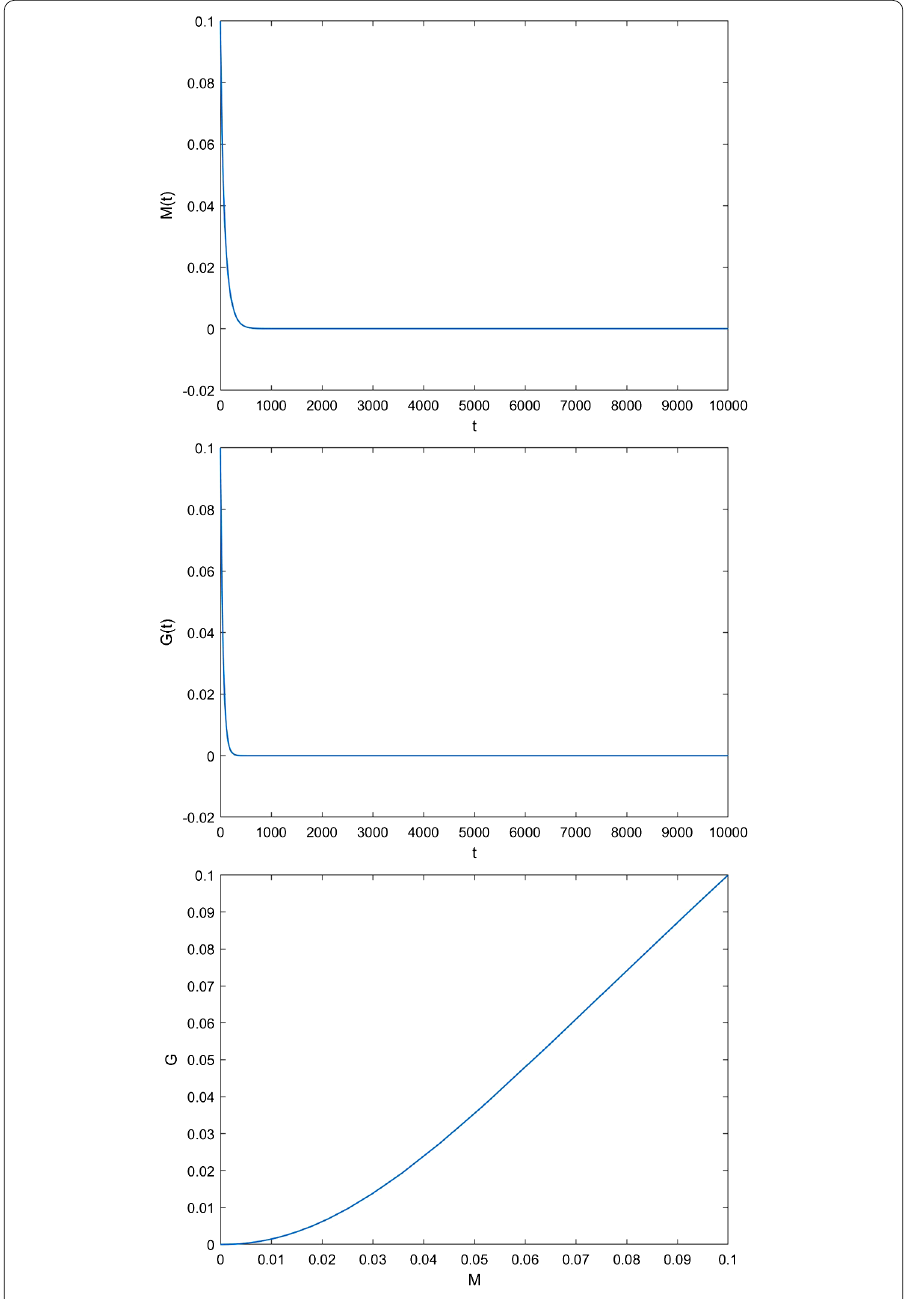
Figure 1 A computer simulation of the system (2.1)–(2.2) with a 1 = 0.05, a 2 = 0.6937, b 1 = 0.0596, b 2 = 0.0206, α 1 = 0.16385, k 1 = 15.64, k 2 = 12.4113, τ = 2, where M (0) = 0.1 and G (0) = 0.1, for which all conditions in Theorem 1 are satisfied. The solution trajectory tends towards a washout steady state as theoretically predicted